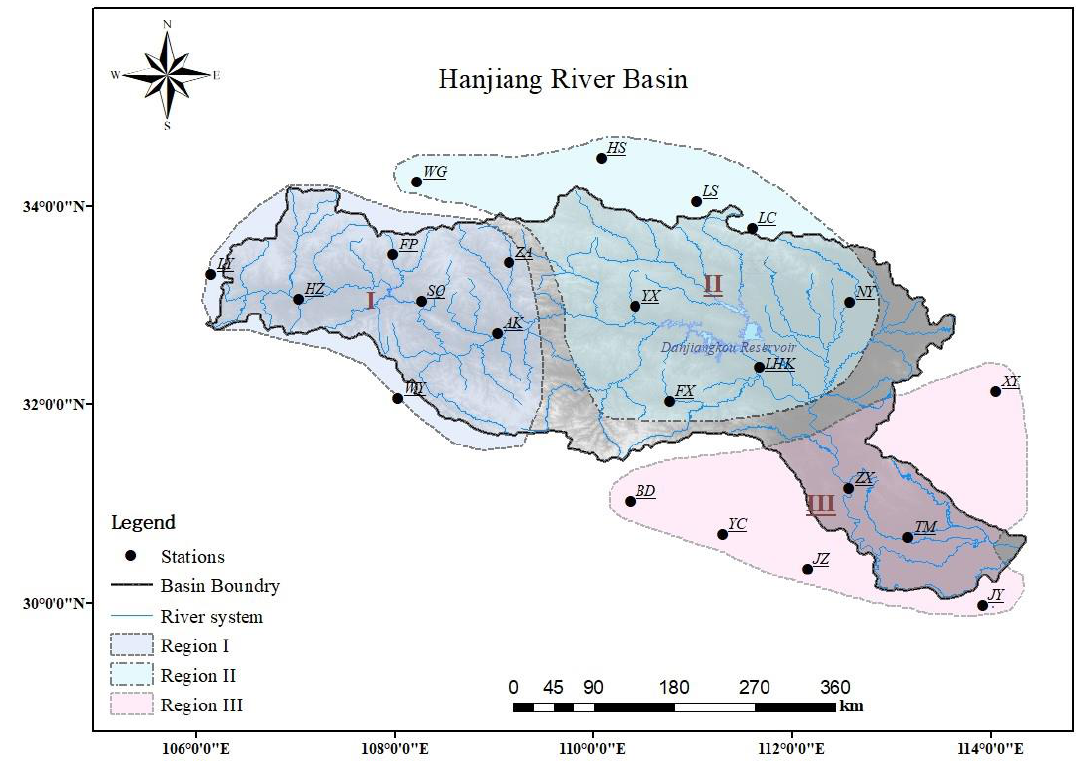
Figure 2. Identification of homogenous sub-regions in the HJRB.